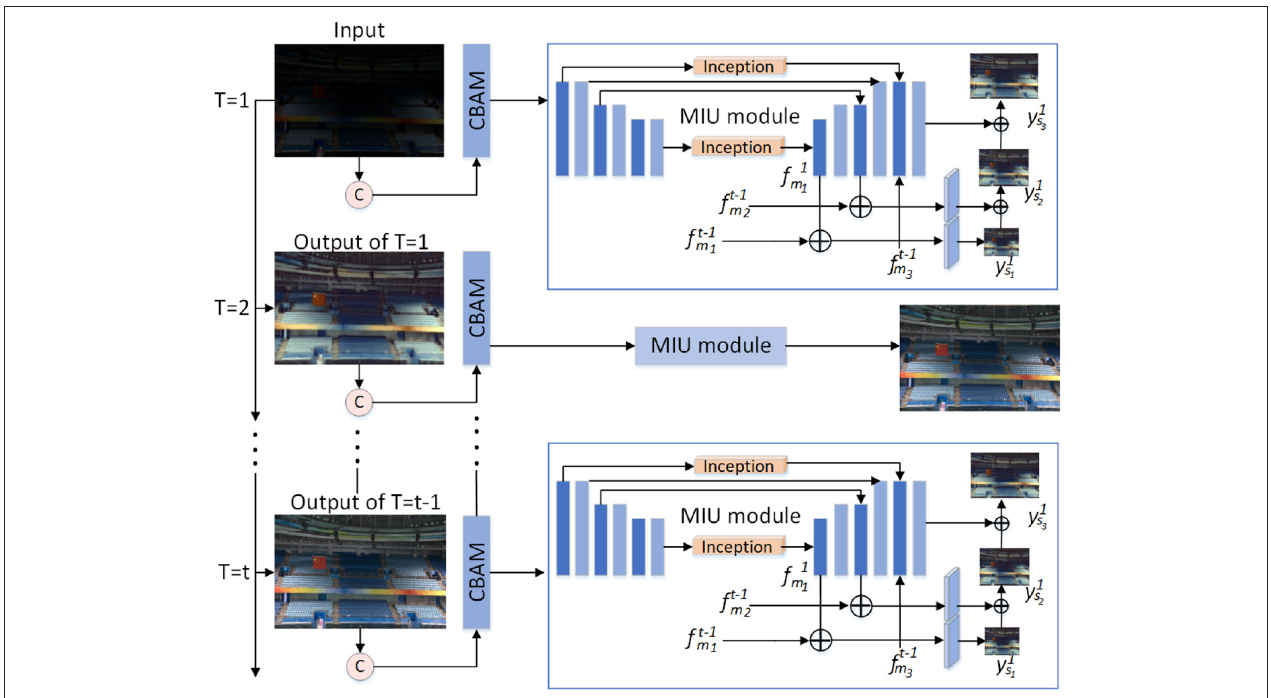
FIGURE 2 | Network structure diagram. Each recursive stage inputs the original low-light image and the enhancement result of the previous recursion. Each recursive stage includes a CBAM module and an multi-scale inception U-Net (MIU) module, which extracts and fuses multi-scale features. Each recursion extracts higher-level feature information, and the final enhancement result is obtained by multiple